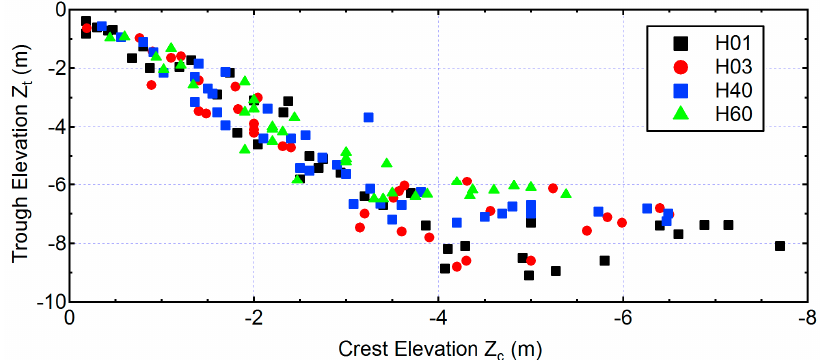
Figure 11. Relationship between crest and trough elevation.